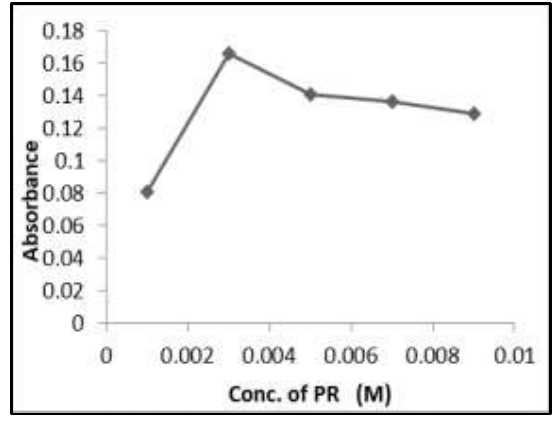
Figure 4. Effect of the reagent concentration